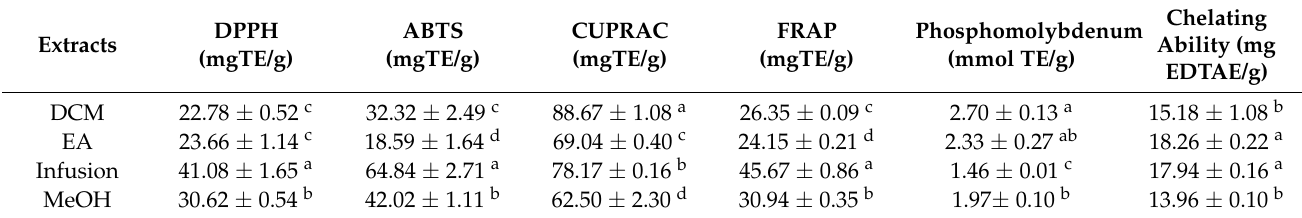
Table 4. Antioxidant properties of the tested extracts